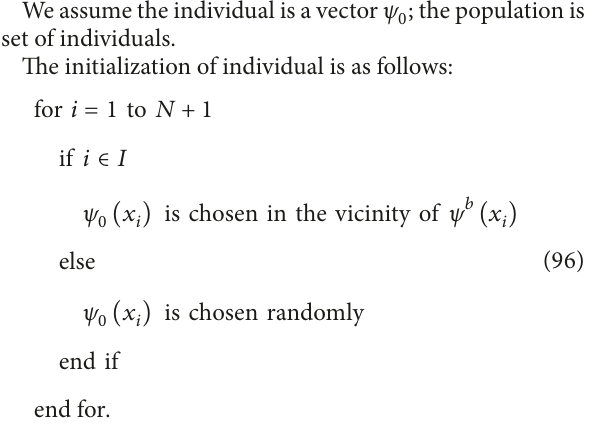
Figure 15: Initial temperature in err = 10% ‖𝜓 exact 0 ‖ 2 case. The recon- structed initial condition began to move away from the true state.